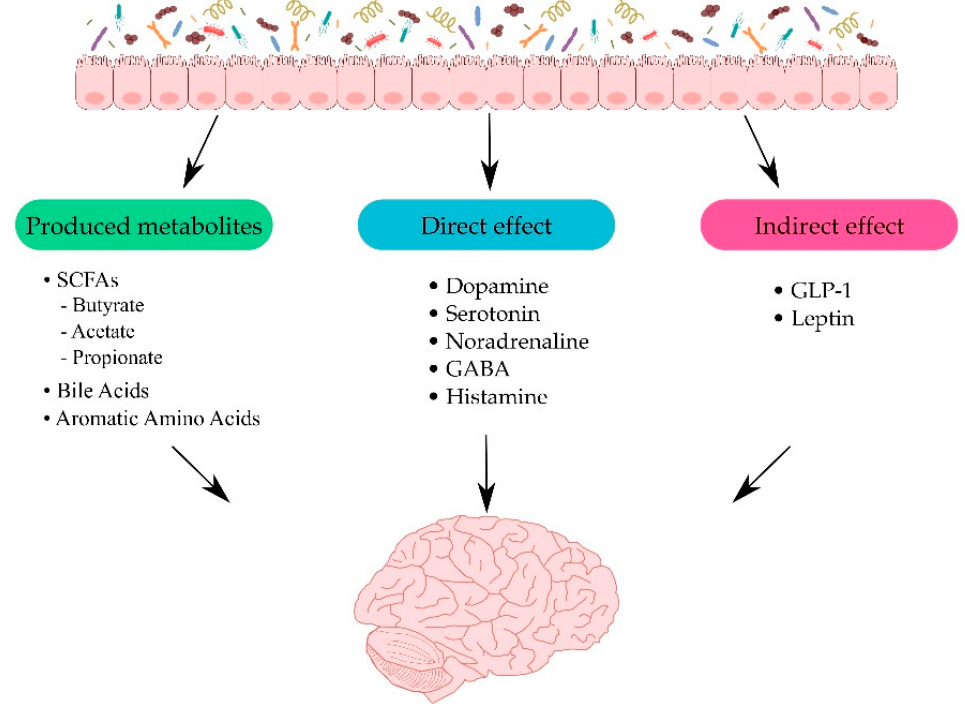
Figure 1. Pathways between the intestines and the central nervous system (CNS). Figure illustrates how the gut microbiota can interact with CNS through several pathways. Firstly, through produced metabolites such as short-chain fatty acids (SCFAs) [38]; secondly, directly with neurotransmitters for example dopamine and serotonin [39–41]; and lastly, indirectly influencing the release of enteric hormones